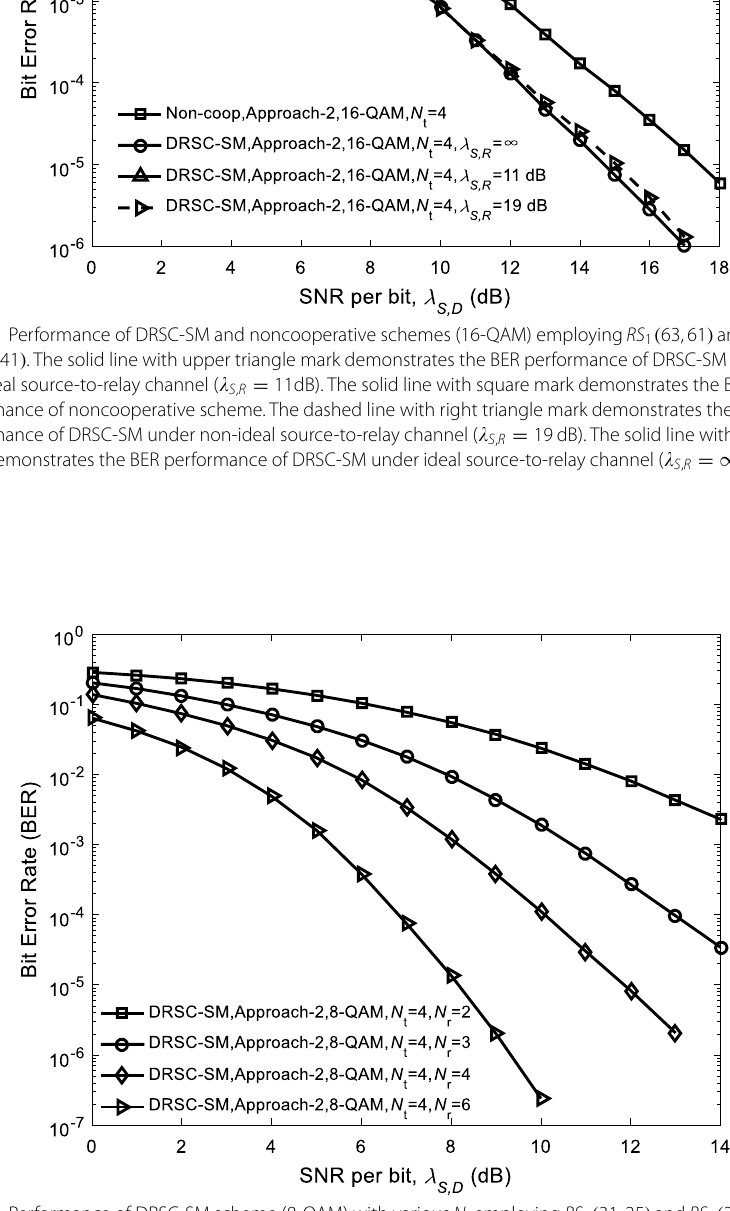
Fig. 15 Performance of DRSC-SM scheme (8-QAM) with various N r employing RS 1 ( 31,25 ) and RS 2 ( 31,13 ) . The solid line with square mark demonstrates the BER performance of DRSC-SM scheme under N r = 2 . The solid line with circle mark demonstrates the BER performance of DRSC-SM scheme under N r = 3 . The solid line with diamond mark demonstrates the BER performance of DRSC-SM scheme under N r = 4 . The solid line with right triangle mark demonstrates the BER performance of DRSC-SM scheme under N r =